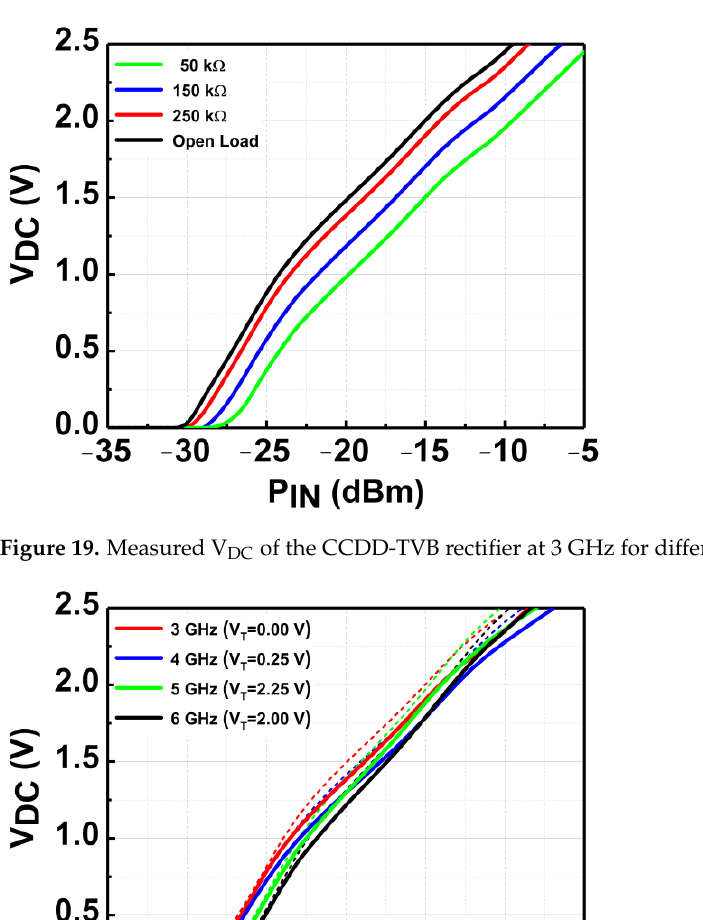
13 of 17 Figure 18. Measurement setup for the validation of CCDD-TVB rectifier. Figure 19 depicts the measured V DC of the CCDD-TVB rectifier for different load con- ditions across the P IN at 3 GHz. It can be observed that as the load is increased from 50 kΩ to 250 kΩ, the sensitivity of the rectifier rises as well. The open -load condition is close to the 250 kΩ load, which is required to achieve the highest sensitivity for the rectifier. Thus, 250 kΩ is selected as the optimum load condition required, and the measurement across fre- quency is conducted. The CCDD-TVB rectifier can deliver a maximum V DC of 2.5 V for P IN of − 7 to − 8 dBm across the frequency when measured with R L = 250 kΩ. The measured results